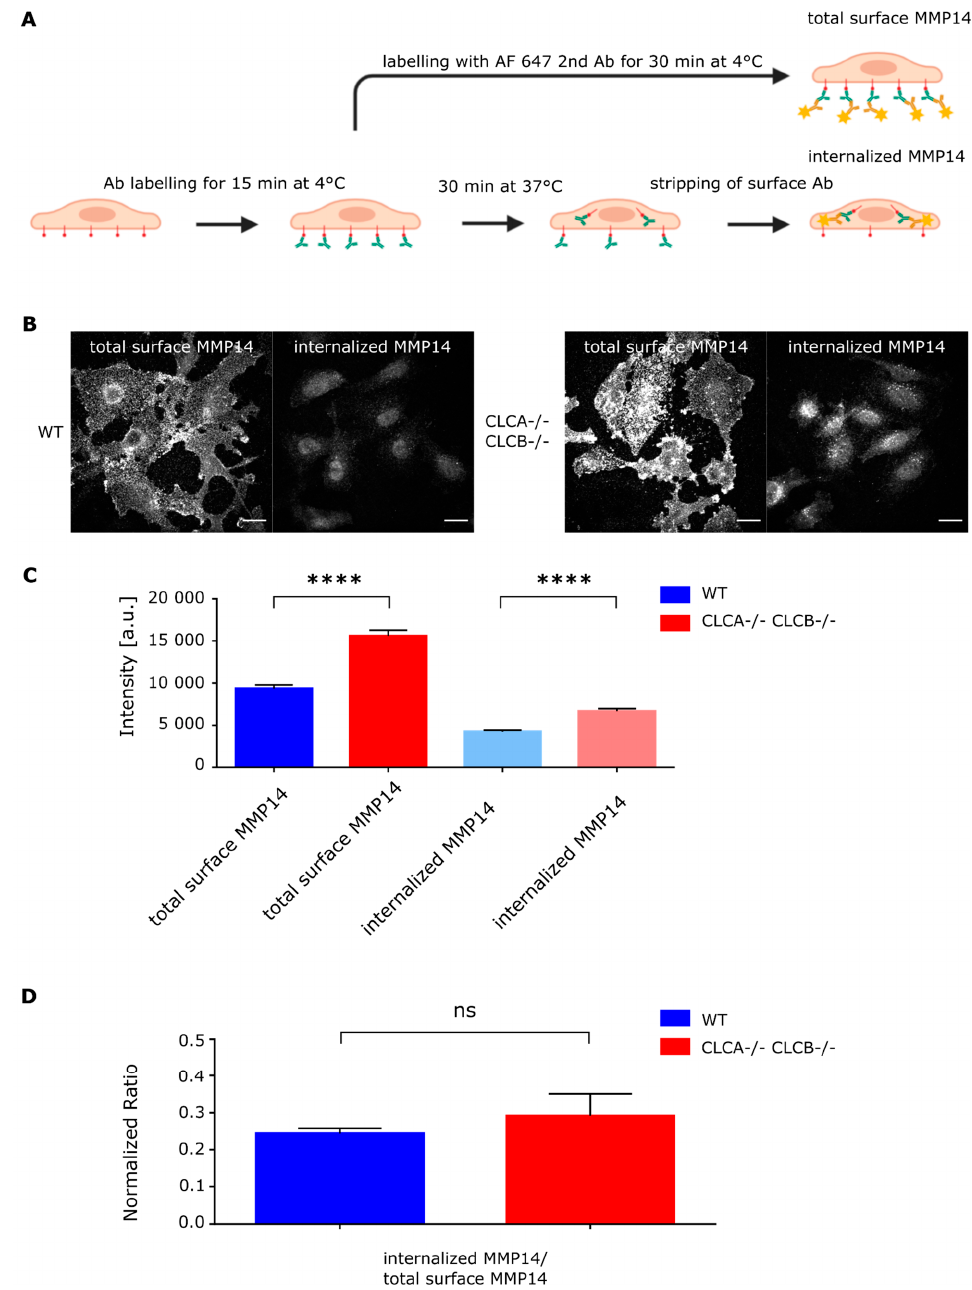
Figure 5. Knock out of CLCA and CLCB does not impair MMP14 internalization. ( A ) Schematic of microscopy based internalization assay. Cells plated on glass coverslips overnight were serum starved for 1 h, labelled with MMP14 antibody on ice for 15 min. For total surface MMP14 levels cells were directly fixed after primary antibody incubation and stained using the Alexa Fluor 647 labelled anti-rabbit secondary antibody (without permeabilization). For internal MMP14 levels cells were incubated at 37 ◦ C for 30 min in order to start MMP14 internalization. For internal MMP14, cell surface was stripped using ice-cold PBS at pH 2.5, followed by fixation and immunostaining with permeabilization. Imaging was performed using confocal microscopy. Image sections were acquired every 0.5 µ m for a total of 7.5 µ m. Fiji was used to quantify MMP14 levels. ( B ) Representative confocal images for total surface and internal MMP14 fractions of U373 AP2-GFP. ( C ) Quantification of MMP14 signal intensities. Shown are the mean with SD. WT total surface 37 cells; WT internalized 38 cells; CLCA − / − CLCB − / − total surface 49 cells; CLCA − / − CLCB − / − internalized 51 cells. Shown are the mean with SD. Statistical analysis: unpaired t -test: total surface MMP14, **** p < 0.0001; internalized MMP14, **** p < 0.0001. ( D ) Intensity ratios from ( C ) of internalized MMP14/total surface MMP14 in U373 AP2-GFP WT and CLCA − / − CLCB − / − cells. Shown are the mean with SD. Statistical analysis: unpaired t -test: not significant